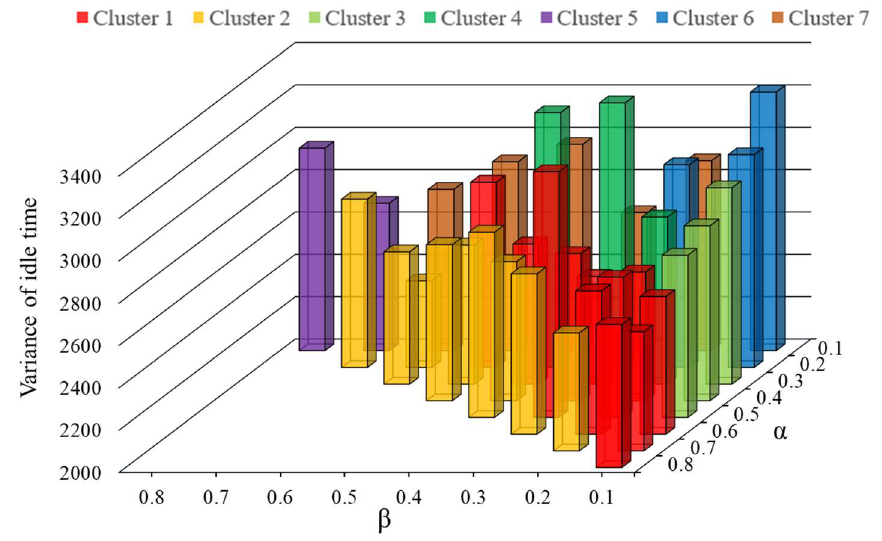
Figure 4. Variance of idle time under different clusters.